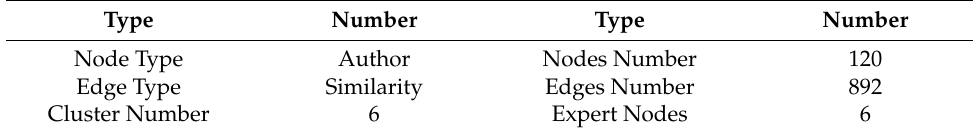
Table 13. Descriptions of authors’ network entities.